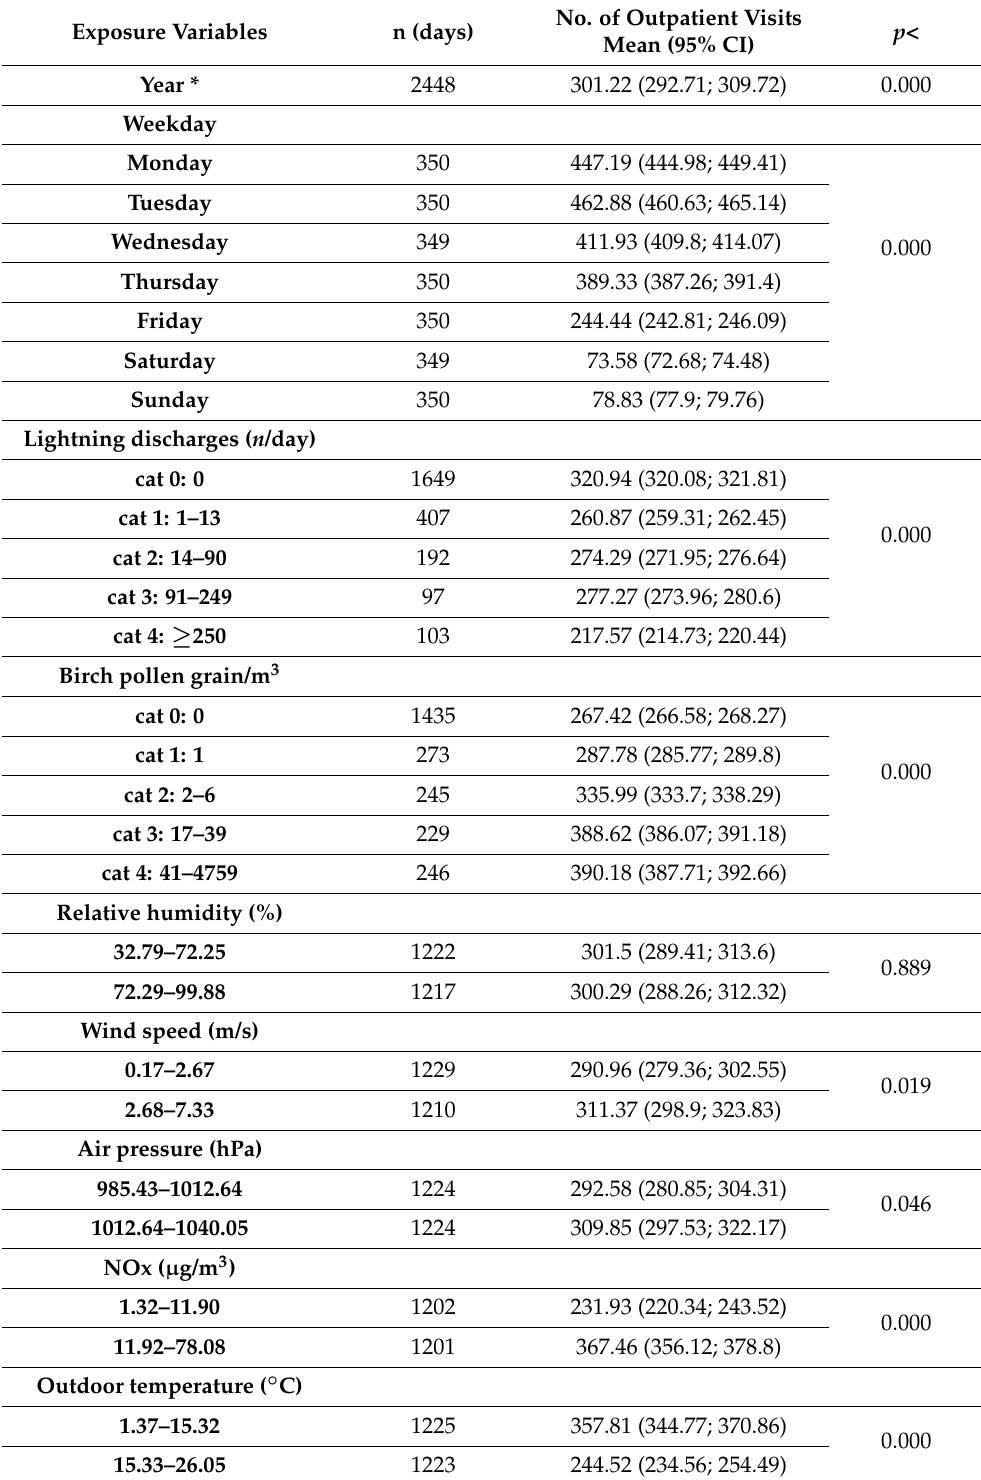
Table 2. Relationship between the number of outpatient visits due to respiratory causes per day and the daily average estimates of the exposure variables. Note: p -values express statistical significance between sub-categories of each variable at the 95% CI